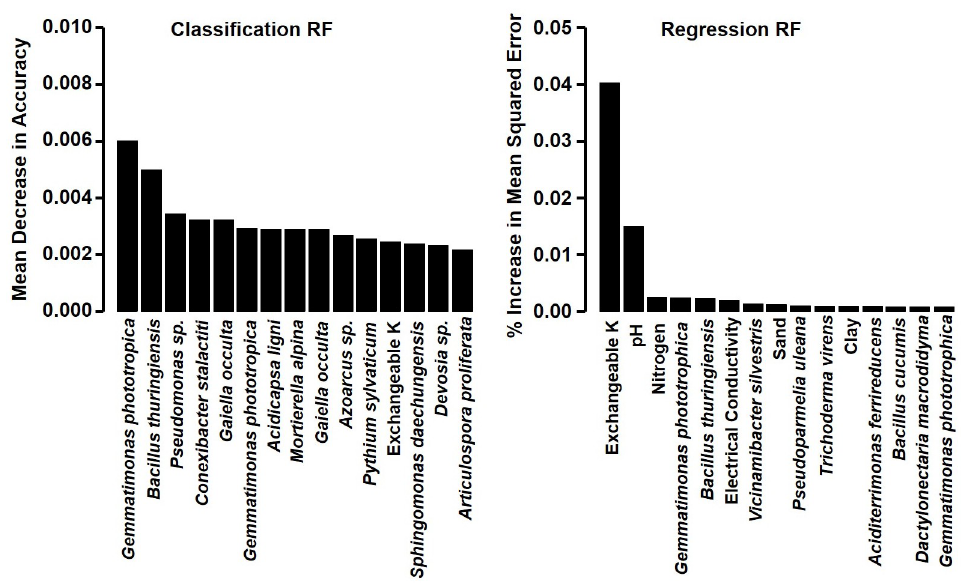
Fig 6. Top 15 most-important features in Random forest modeling for discrimination between PRD-inducing and non-inducing soils. In the RF-classification model, variable importance was indicated and listed in order by the mean decrease in accuracy. In the RF-regression model, variable importance was indicated and listed in order by percent increase in mean squared error. Performance and accuracy were significant in each model (kappa value of 0.92 for classification model and low mean absolute error of 0.083 for regression